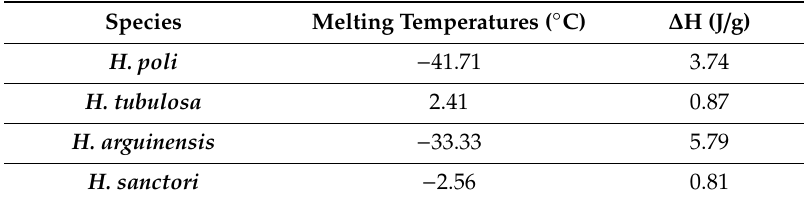
Table 4. Melting temperatures and fusion enthalpies ( ∆ H) of the studied sea cucumbers oils determined by DSC ( − 80–80 ◦